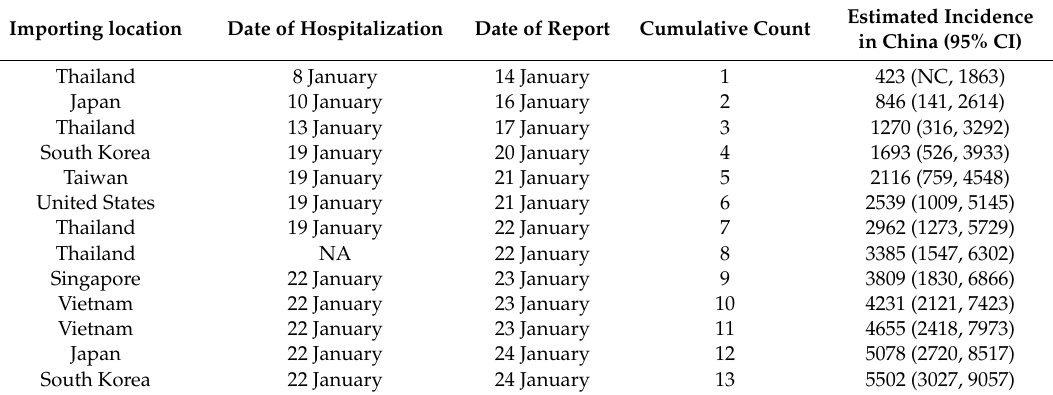
Table 1. Exportation events and estimated incidence in